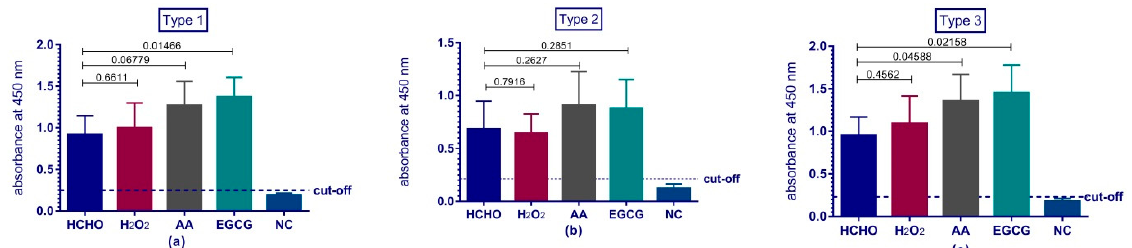
Figure 3. Immune response to the inactivated trivalent bulks in rats’ sera IgG antibodies were determined by ELISA. Serial two fold dilutions of sera obtained from rats immunized with one of the four vaccine preparations (HCHO, H 2 O 2 , AA or EGCG) and the sera of unimmunized control group (NC). Data is the mean absorbance of duplicate wells and error bars show the standard deviation (SD). Cut-off value is mean absorbance of diluent control +2 SD and is represented by a horizontal dashed line. The capped lines represent the compared groups and the numbers written above the capped lines are the p -values. ( a ) PV1 results, ( b ) PV2 results and ( c ) PV3 results.